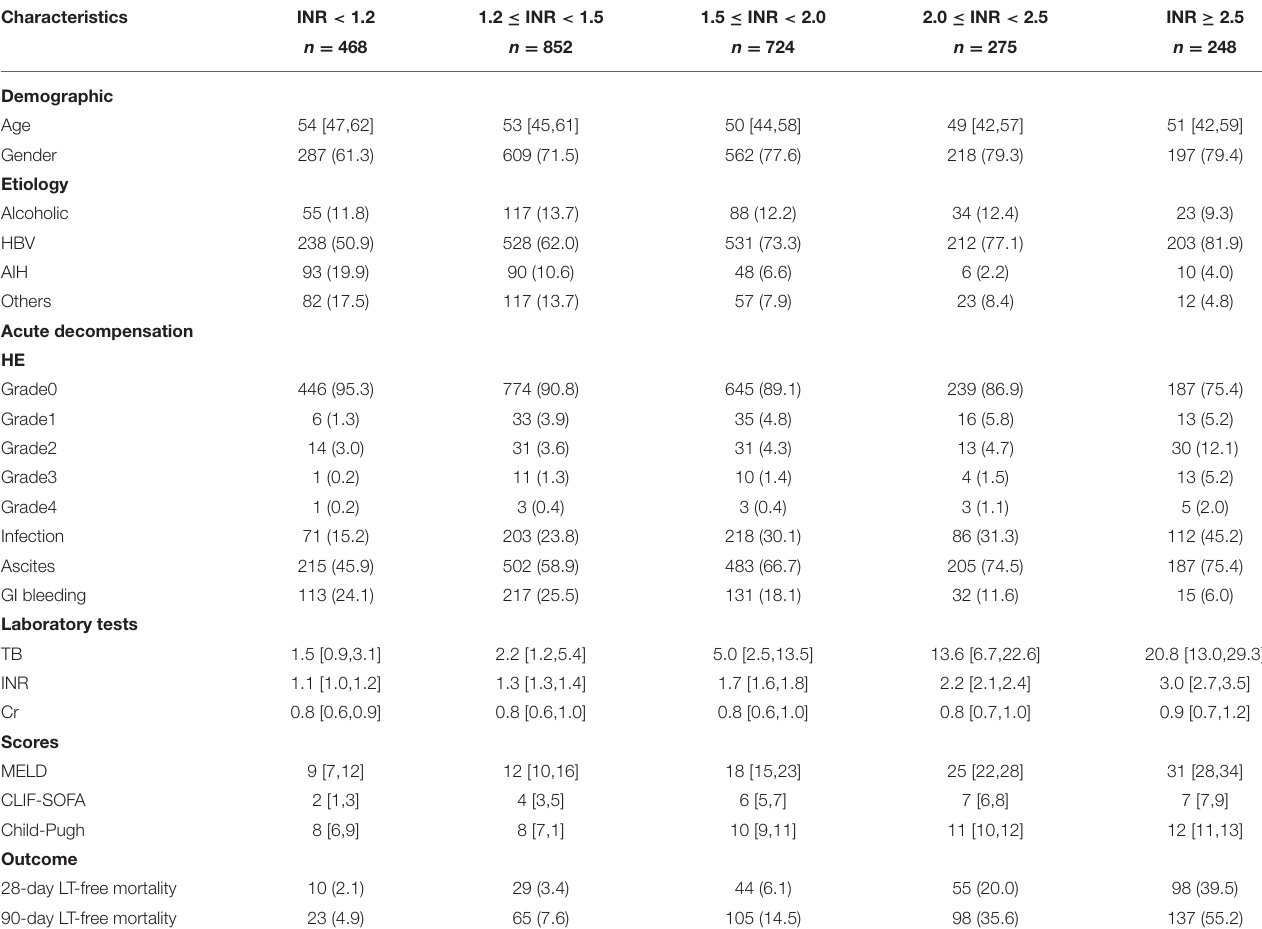
TABLE 1 | Baseline characteristics of patients with cirrhosis based on different INR groups at admission.